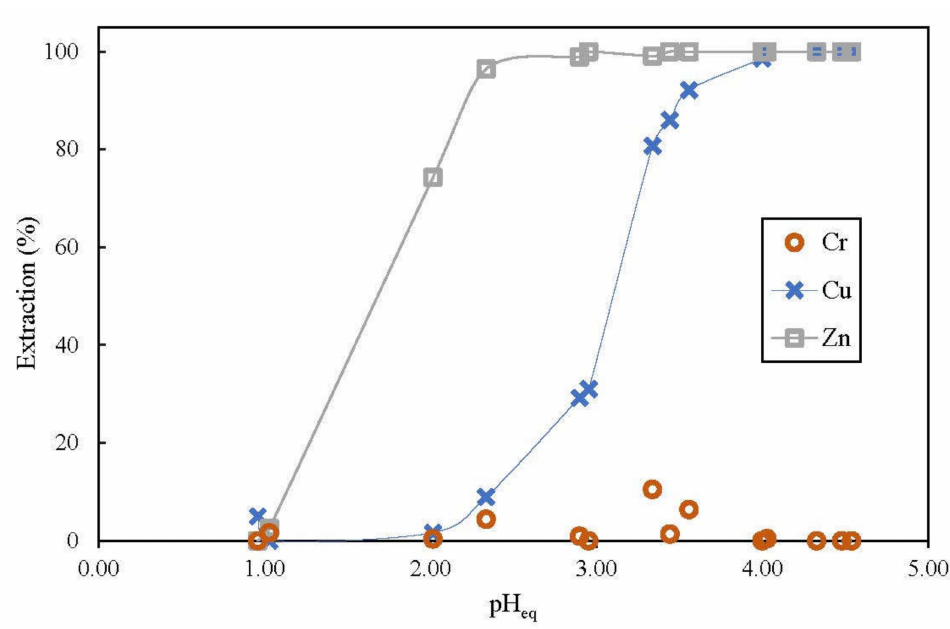
Figure 3. Effect of pH eq on extraction of metal ions from feed containing 100 ppm chromium (VI), copper and zinc; organic phase consisted of 3% ( v / v ) D2EHPA in kerosene, extraction time = 5